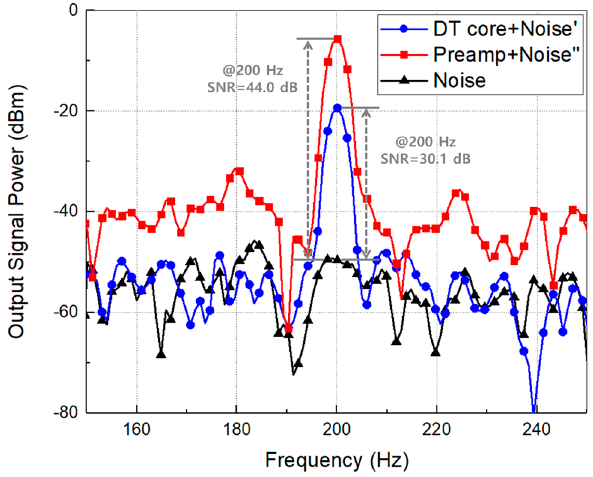
Figure 7. Measured voltage responsivity and noise equivalent power (NEP): ( a ) A detector without the preamplifier; ( b ) A detector including the preamplifier.